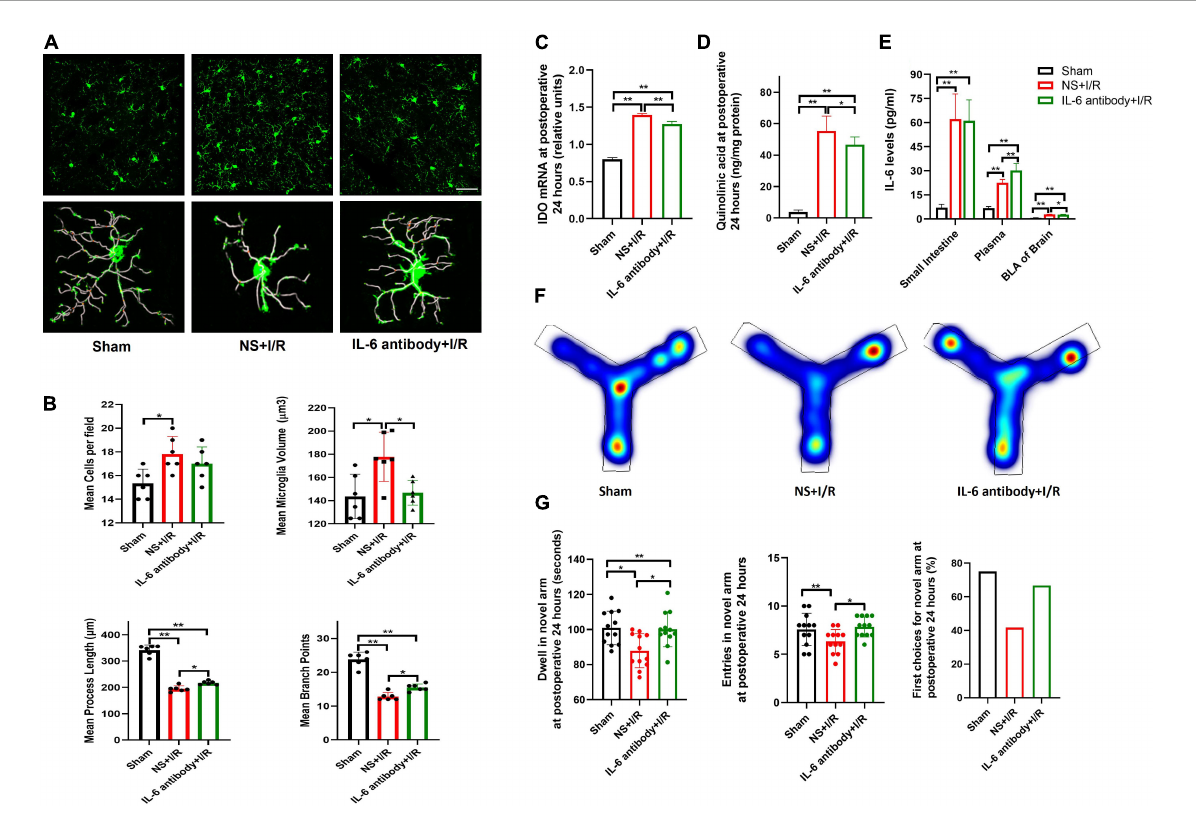
FIGURE5 Neutralizing peripheral IL-6 reduced microglia reactivation and IDO-1/QUIN in BLA that improved the cognition in the model mice. (A) Immunofluorescence staining and skeleton of microglia. (B) Analysis of microglia reactivation. (C) IDO-1 mRNA expression in BLA. (D) QUIN levels in BLA. (E) IL-6 levels in intestine, plasma and BLA. (F) Heating map of Y Maze Test. (G) Results of Y Maze Test. N = 10–12 per group for Y maze testing, N = 8 for others, * P < 0.05, ** P < 0.01. I/R, ischemia and reperfusion; BLA, basolateral amygdala; NS, normal saline; IL-6 antibody, Interleukin 6